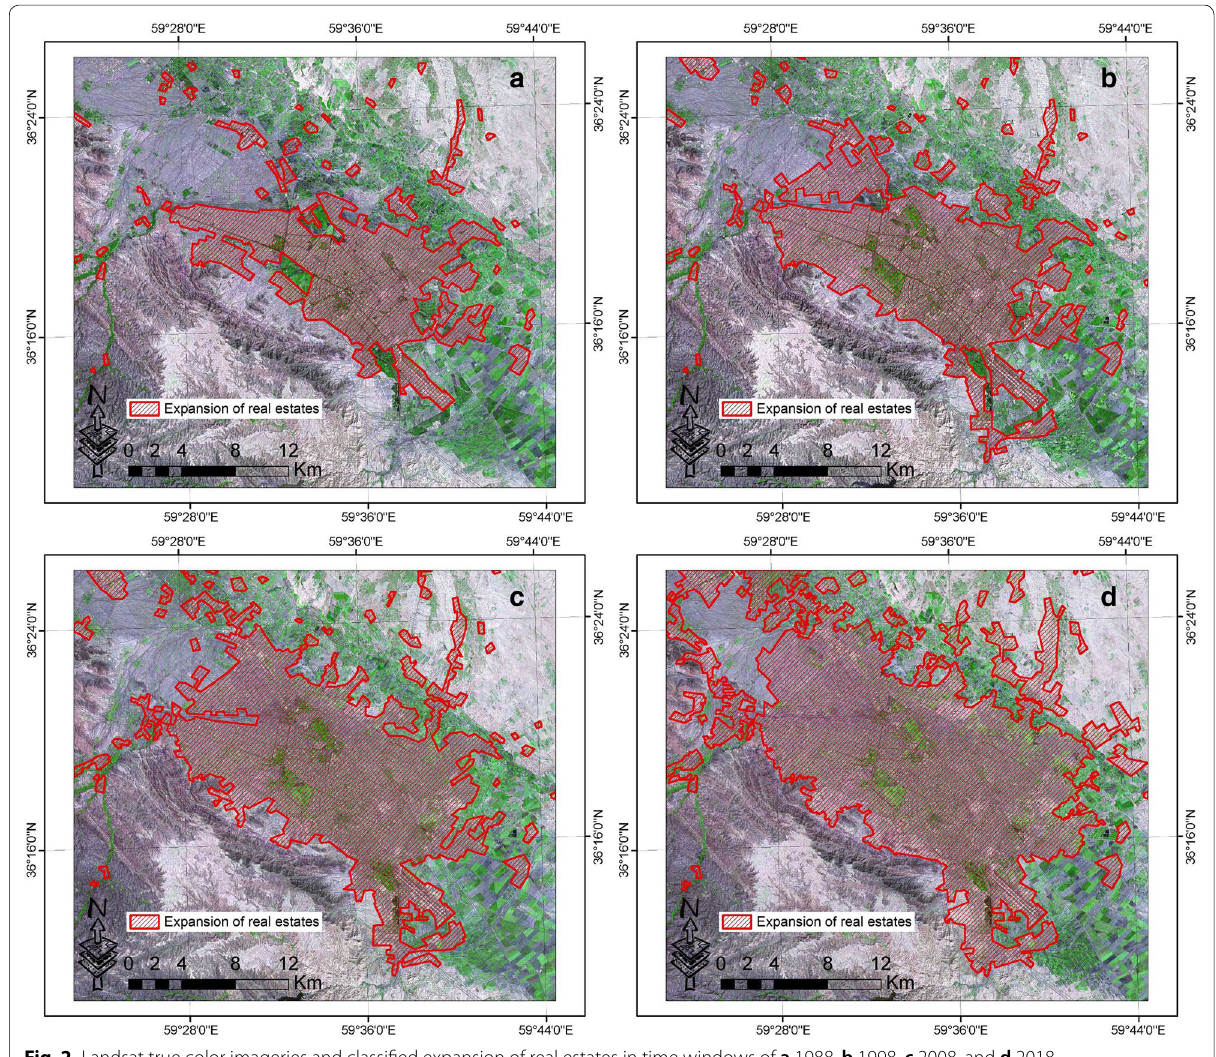
Fig. 2 Landsat true color imageries and classified expansion of real estates in time windows of a 1988, b 1998, c 2008, and d 2018